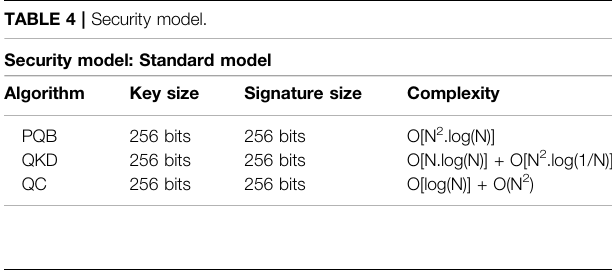
TABLE 5 | Avalanche